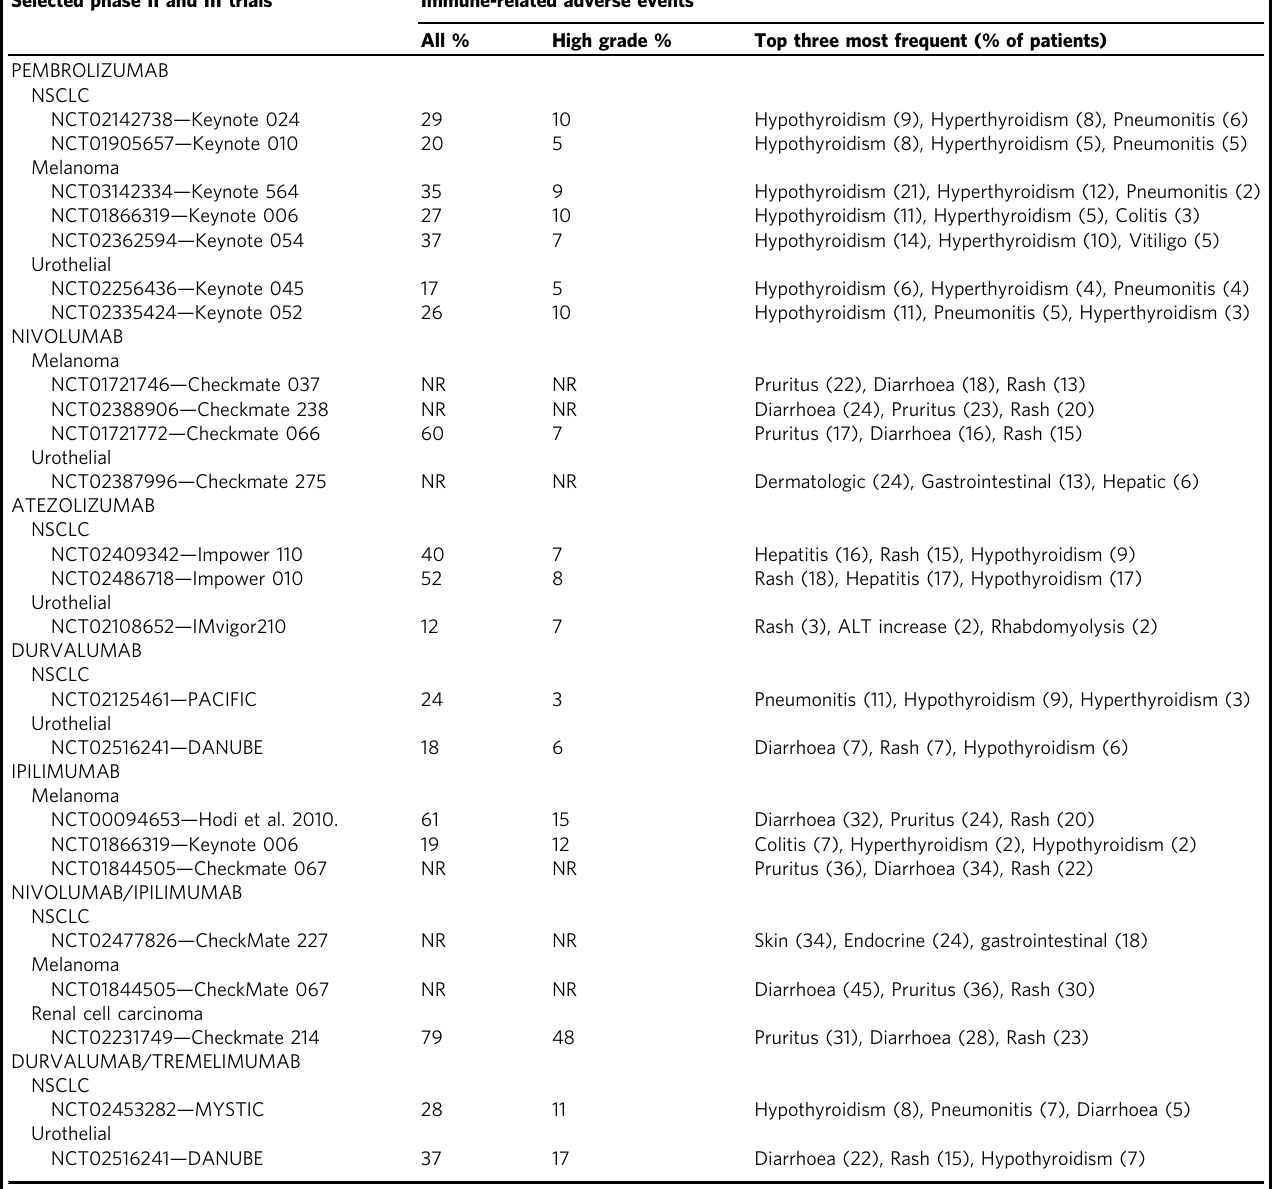
Table 1 Prevalence of irAEs and high-grade irAEs in major immunotherapy clinical trials. Selected phase II and III